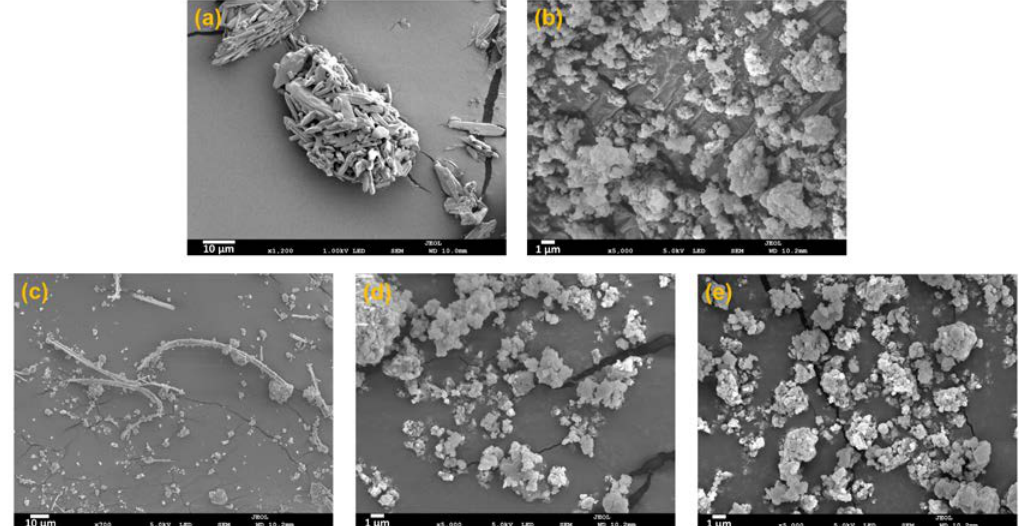
Figure 10. SEM images: ( a ) raw orlistat, ( b ) raw Neusilin ® UFL2, Neusilin ® UFL2: orlistat = 1:1.2 ( w/w ) samples prepared by MA-SCF at ( c ) 308.15 K and 10 MPa and ( d ) 318.15 K and 10 MPa, and ( e ) Neusilin ® UFL2: orlistat = 1:0.8 ( w/w ) sample prepared by MA-SCF at 318.15 K and 10 MPa.